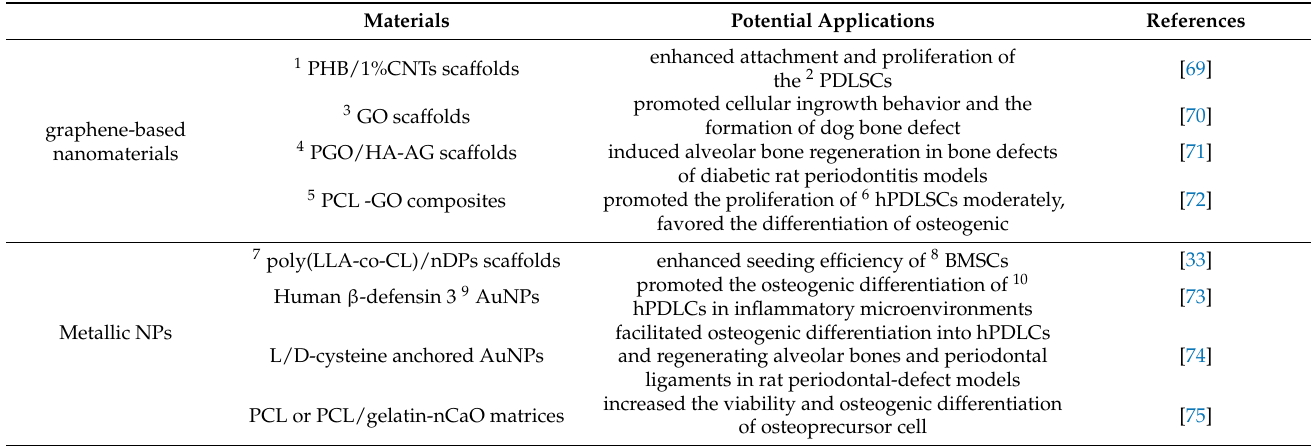
Table 3. List of nanomaterials for regeneration in periodontal tissue engineering.